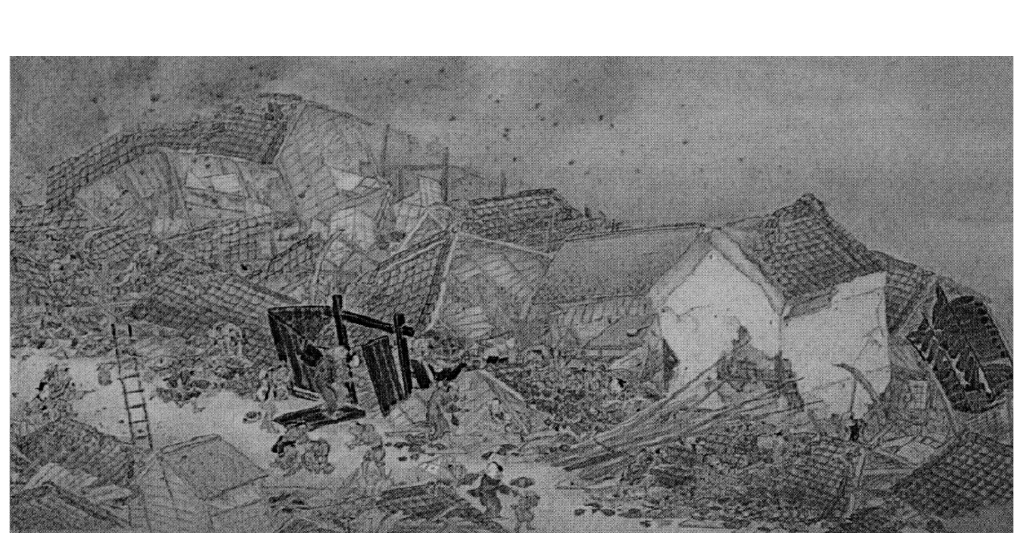
Fig. 2. The Great Ansei-Edo earthquake (11 November 1855) in a section of a coeval painted